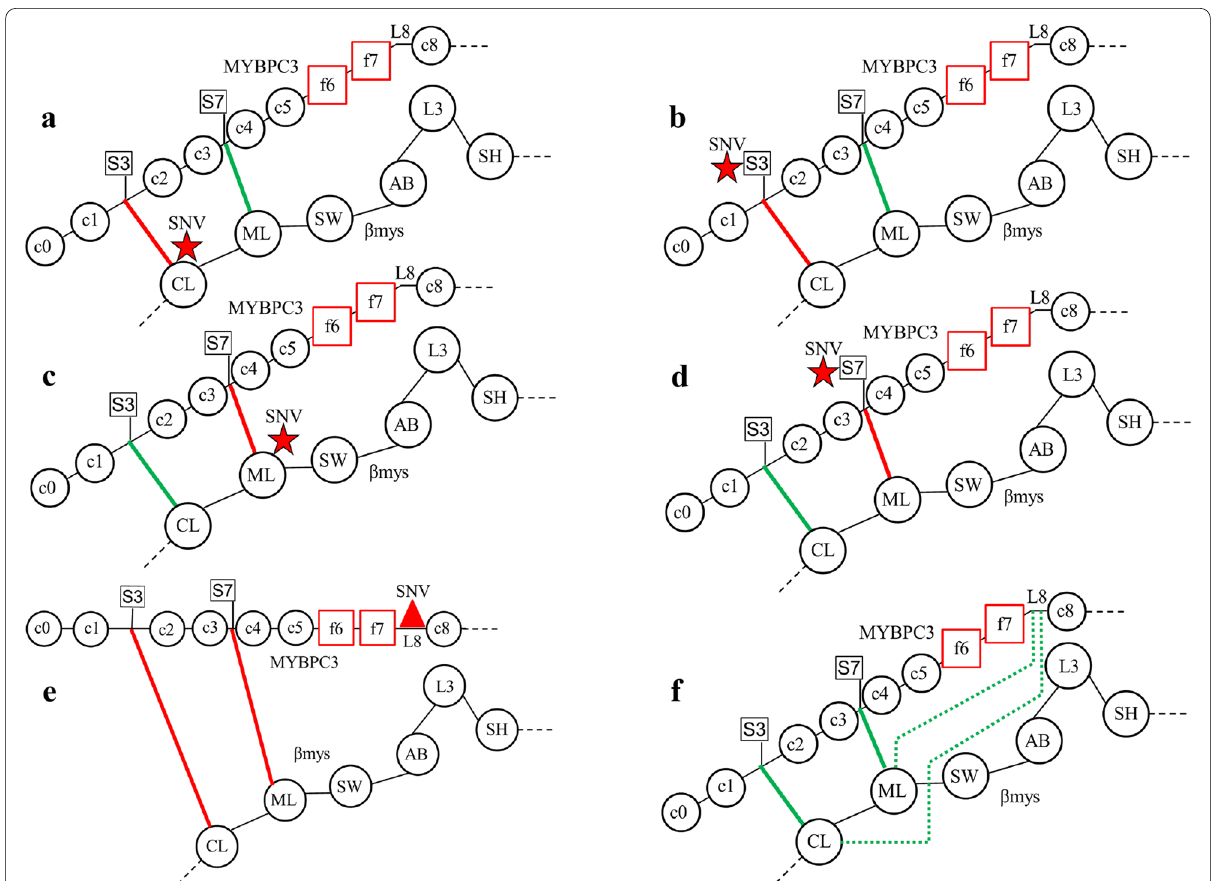
Fig. 3 Hypothetical βmys/MYBPC3 complexes in human populations for SNVs detecting real and virtual co-domains. Functional domains CL and ML in βmys, and, functional domains S3 and S7 in MYBPC3 are SNV modified individually as shown in a , c , b , and d . Complexes SNV (red star) modified at C-loop ( a ), phosphorylatable serine S3 ( b ), myopathy loop ( c ), or phosphorylatable serine S7 ( d ) are species needed in the database to surmise the co-domain interactions in the native species shown in f . The native complex involves real co-domains indicated by the solid green lines between S3 and CL and between S7 and ML. Co-domain interruption by SNVs is indicated by the solid red lines connecting S3-CL or S7-ML in a‑d . SNV modification in e locates to L8 (red triangle) where it alters MYBPC3 conformation to interrupt real co-domains S3-CL and S7-ML. The virtual co-domains L8-CL and L8-ML are indicated by the broken green lines in